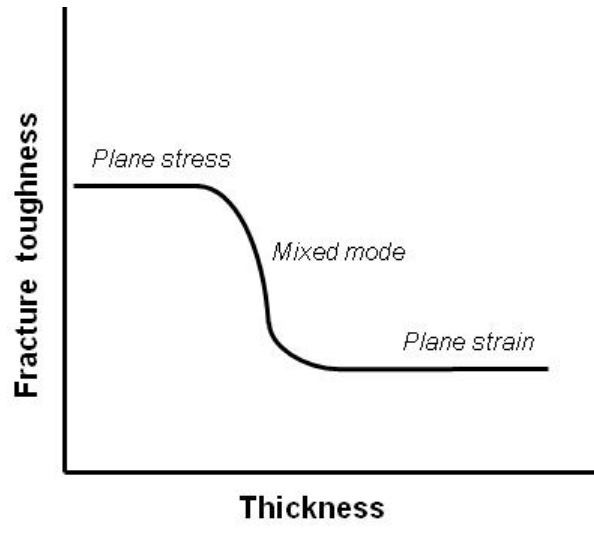
Figure 7. Influence of specimen thickness on the fracture toughness values and related stress states (adapted from